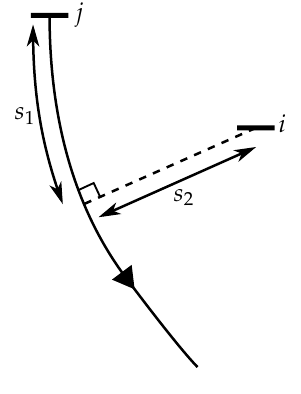
Figure 5. Distance ~ X ij ( s 1 , s 2 ) for TEC rotor i relative to the streamline of rotor j , where s 1 is the distance along the streamline to the shortest orthogonal projection from rotor i and s 2 is the distance from i to the point of intersection. If more than one orthogonal projection exists, then the projection with the minimum s 1 is selected.